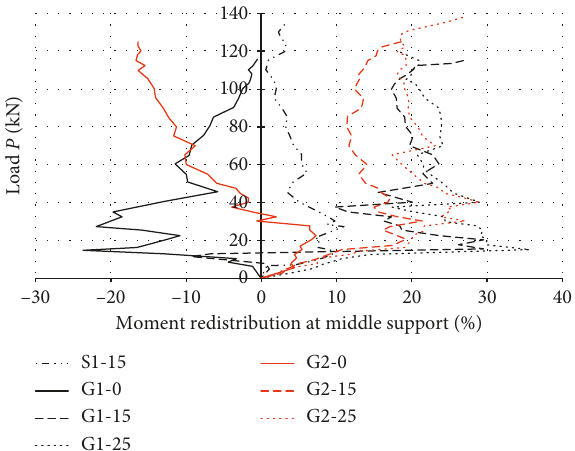
Figure 10: Load-percentage of moment redistribution relationship at the middle support for tested beams.